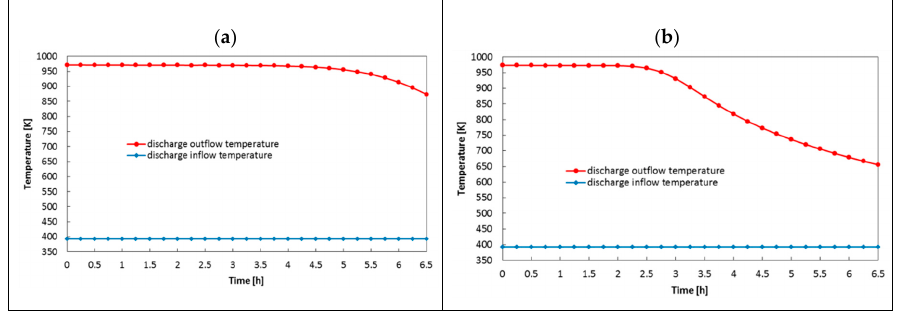
Figure 15. Discharging in-/outflow temperature over discharging duration: Cylinder distributor ( a ) and no distributor ( b ).